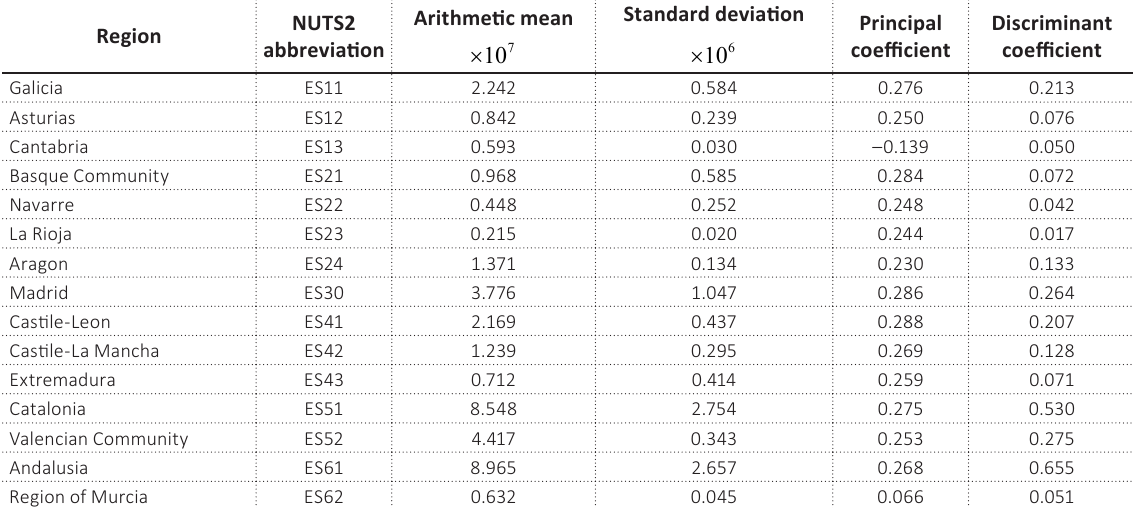
Table 2. Capacity for mainland Spain on descriptive statistics, principal component analysis, and discriminant